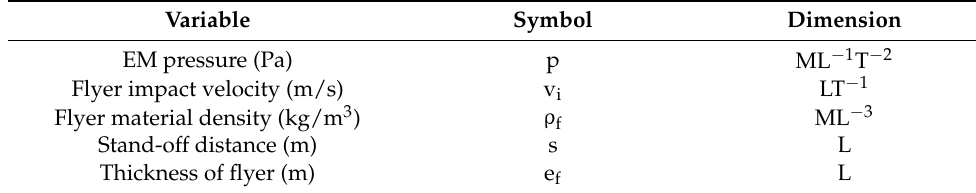
Table 3. Variables and their dimensions in the MLT system for the dimensional analysis of the flyer impact velocity for MPW of tubes and sheets. Variable Symbol